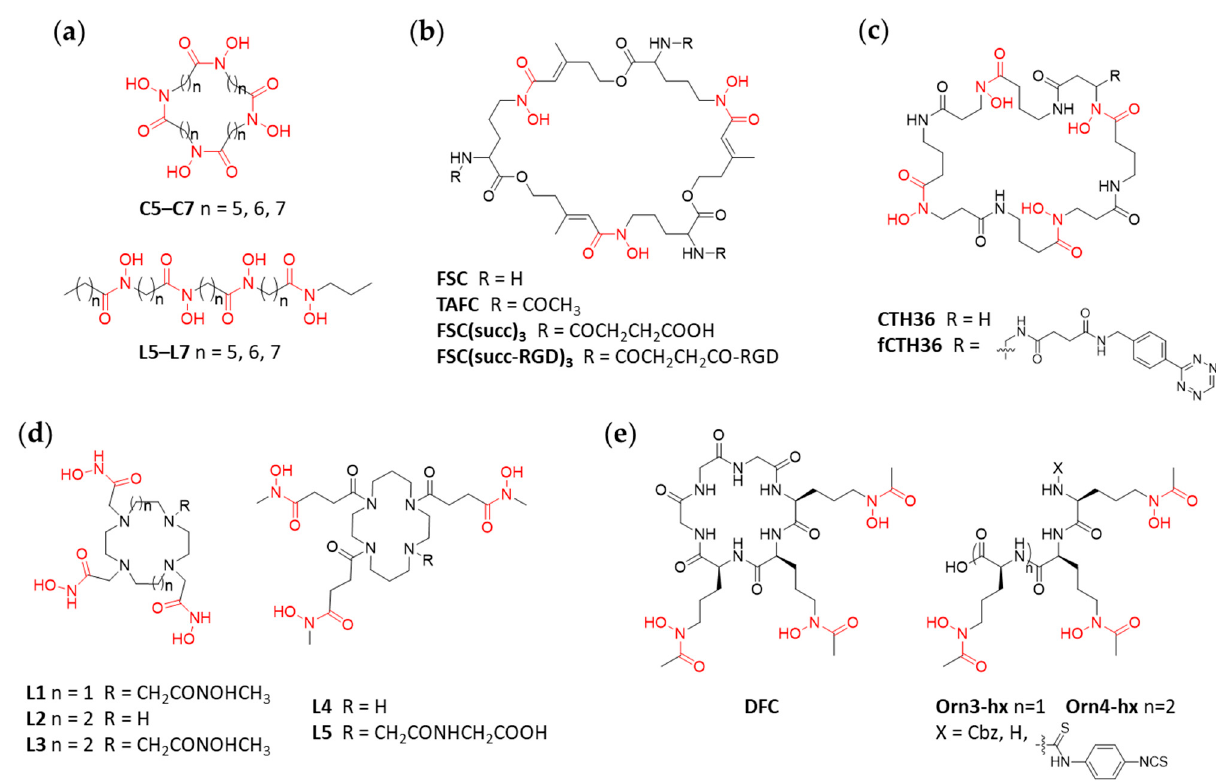
Figure 5. Structures for cyclic not-DFO-based hydroxamate 89 Zr-chelators and linear derivatives. ( a ) Three macrocycles C5–C7 and their acyclic analogs L5–L7. ( b ) The macrocyclic Fusarinine C (FSC) and derivatives. ( c ) A Cyclic Tetra-Hydroxamate (CTH) 36-membered macrocycle. ( d ) Cyclen- (L1–L3) and cyclam- (L4, L5) based macrocycles. ( e ) The macrocyclic desferrichrome (DFC) and its linear derivatives Orn3-hx/Orn4-hx with three or four hydroxamates, respectively.